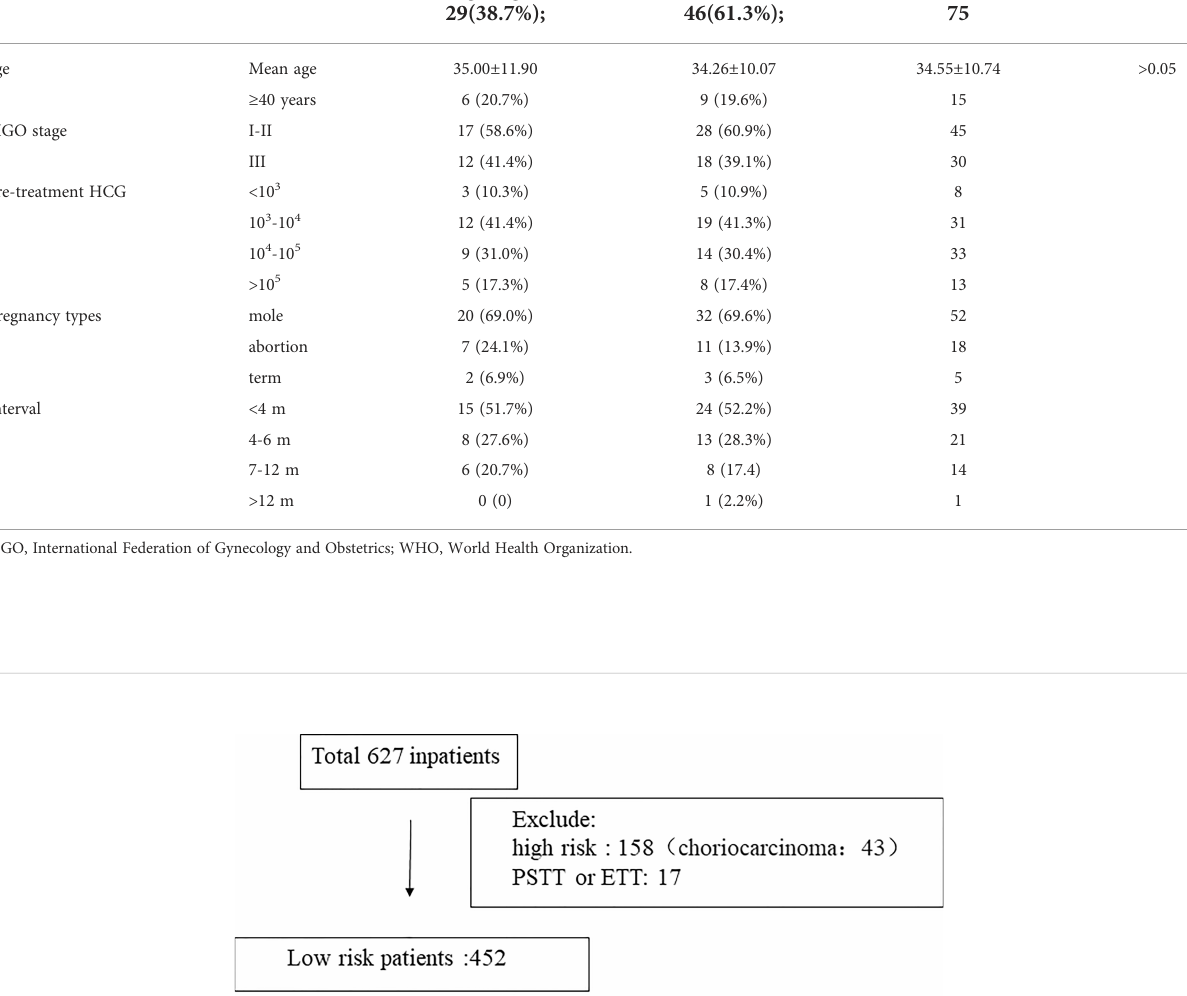
TABLE 1 The baseline of patients with FIGO/WHO prognostic score(5-6).